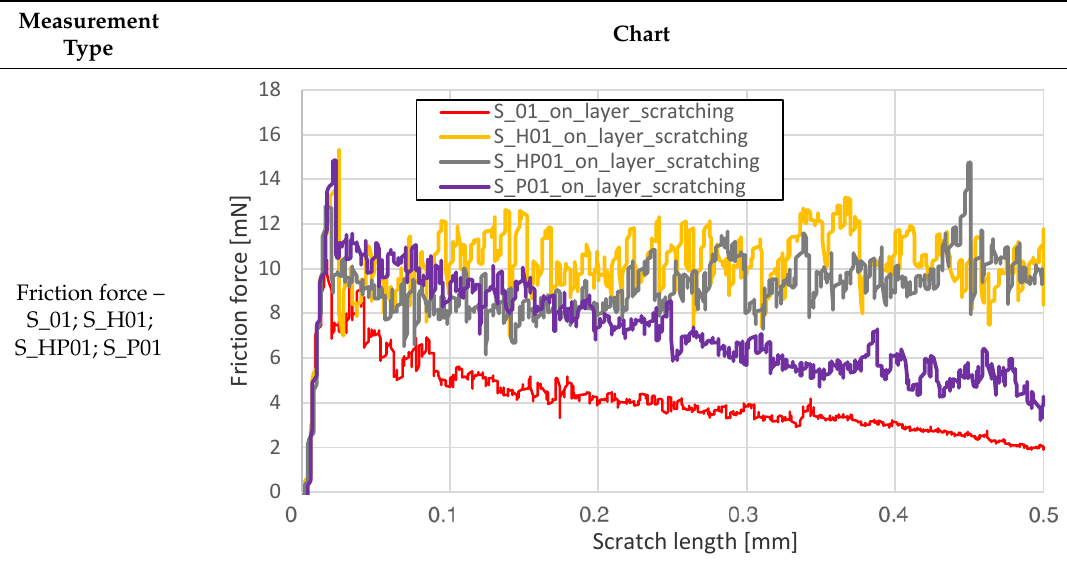
Table 5. Friction force values and sclerometric hardness measured in XY plane of the samples after di ff erent types of processing (as build, underwent HIP, and precipitation annealed).